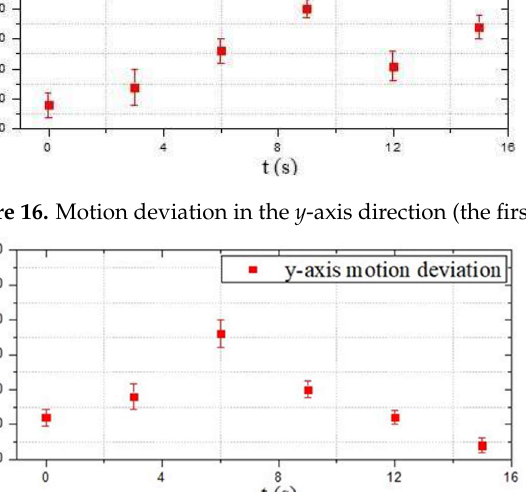
Figure 17. Motion deviation in the z-axis direction. (the first experiment).